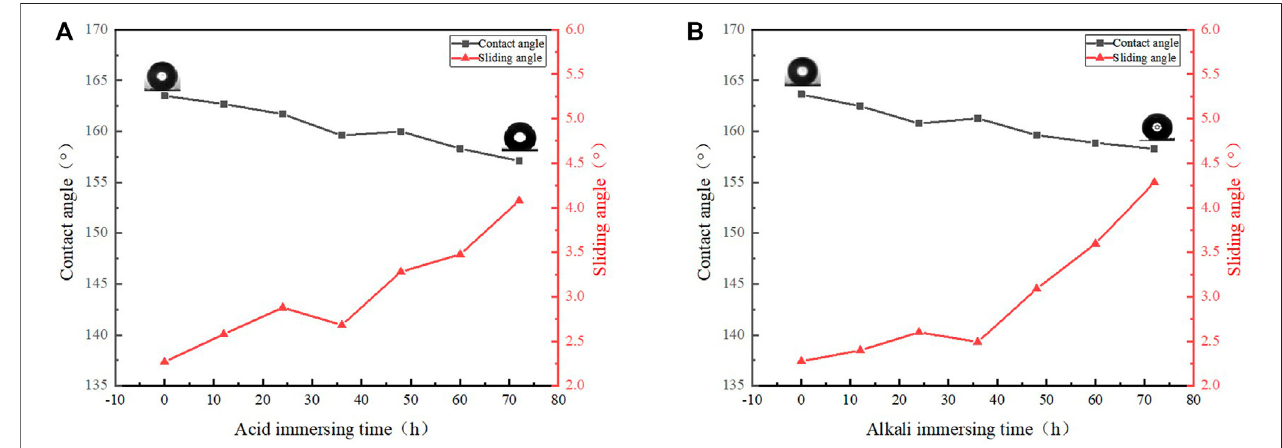
FIGURE 8 | (A) Acid immersing result, (B) Alkali immersing result.